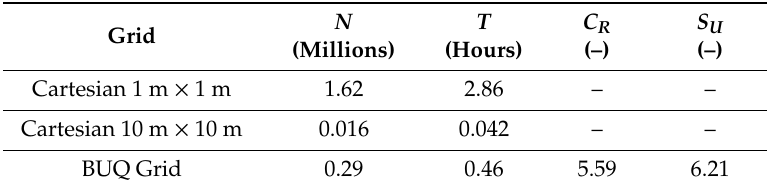
Figure 7. Hydrographs at the end of each hillside and at the channel outlet for different configurations of the Parflood Rain model compared to the kinematic flow wave solution.